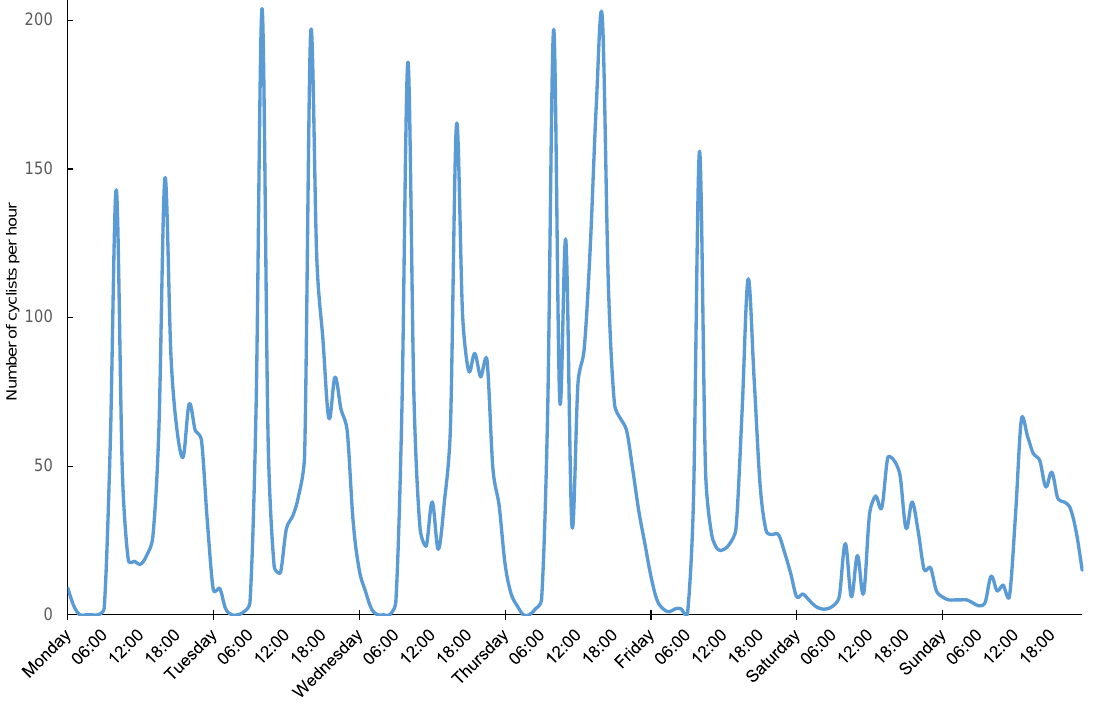
Figure 2. Variation in cycle intensity in a typical week in the spring of 2011 (9-15th May).